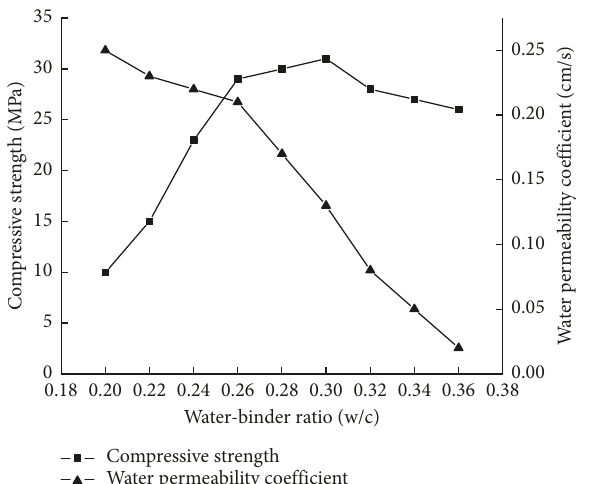
Figure 11: Relationship between porosity and compressive